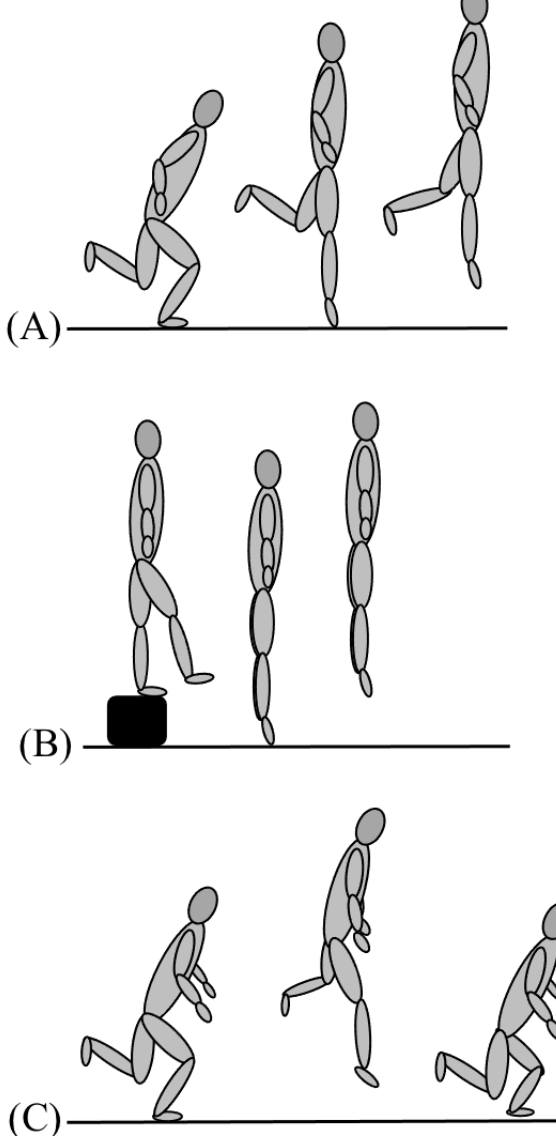
Figure 3. Illustration of the different phases of the different plyometric exercises. A unilateral countermovement jump: ( A ) countermovement, take-off, mid-air. ( B ) Drop-jump; “walk-out”, take-off, mid-air. ( C ) Skate-jump; countermovement, take-off in the lateral direction, impact with the alternating leg.